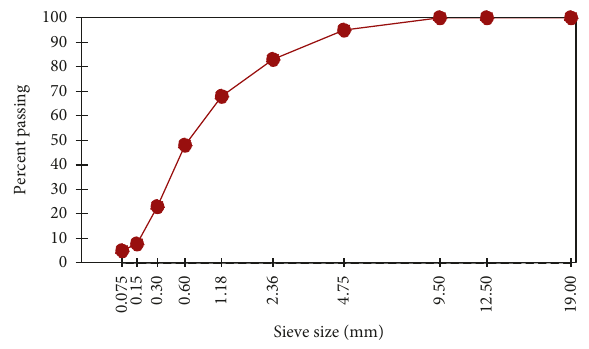
Figure 2: Gradation of strontium slag. Table 2: Chemical composition of strontium slag and fly ash.